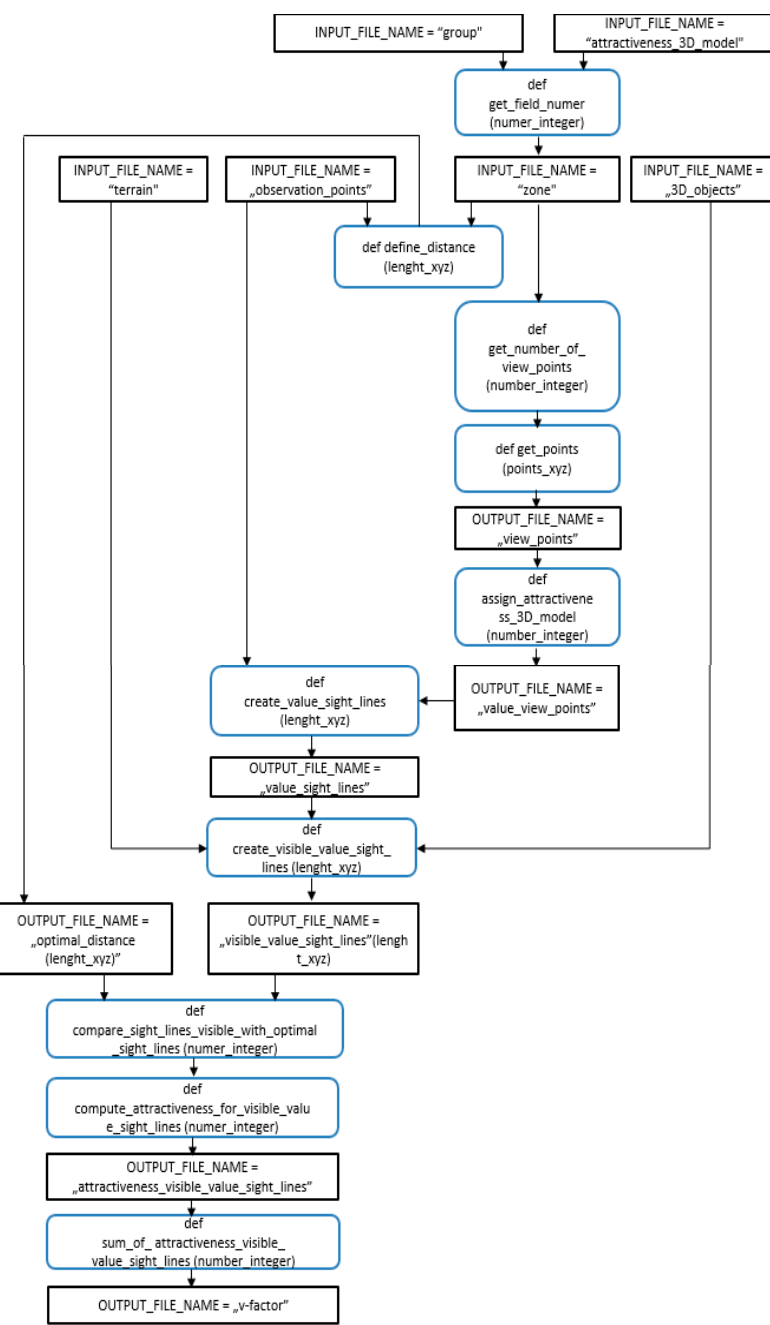
Figure 9. V-factor algorithm. Source: own Figure 9. V ‐ factor algorithm. Source: own work.